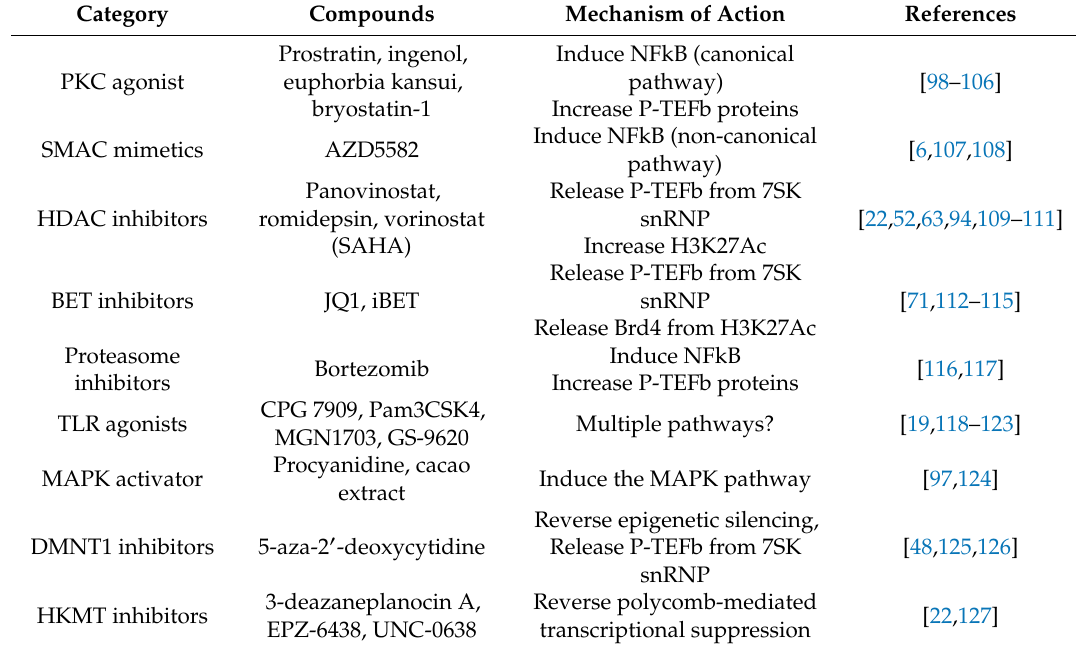
Table 1. Examples of